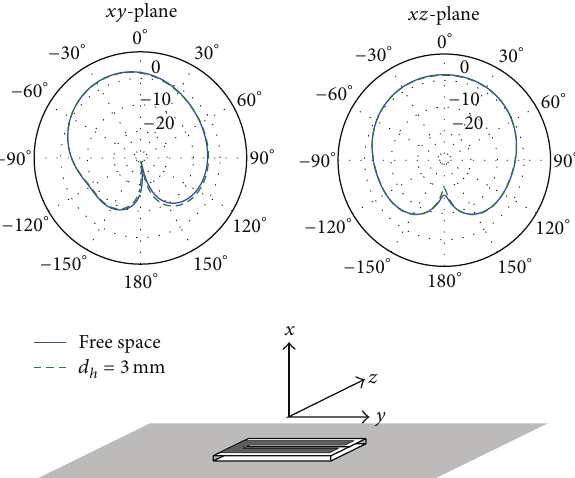
Figure 6: Simulated antenna (without silver fabric) reflection coefficient in free space at various distances from the human body.